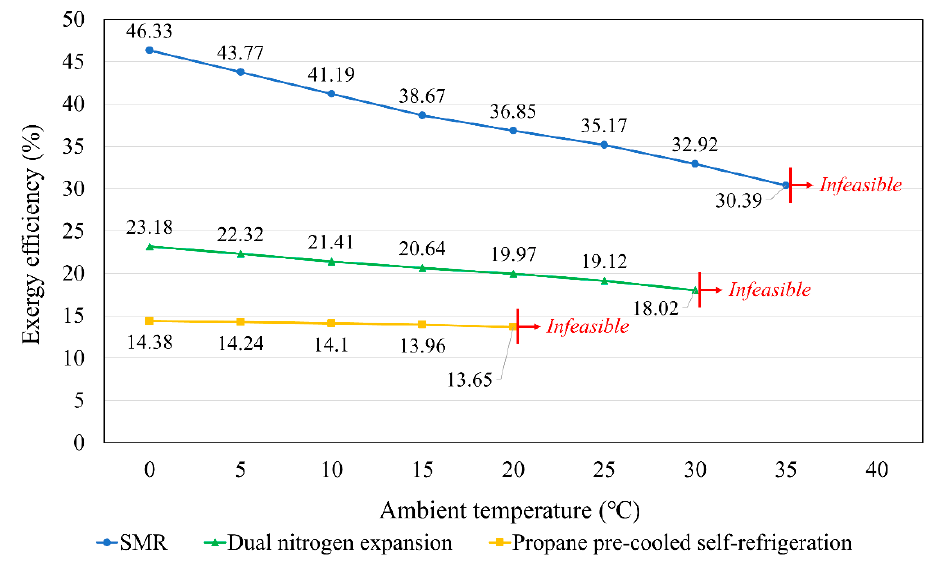
Figure 13. Effects of ambient temperature on exergy efficiency of each process.